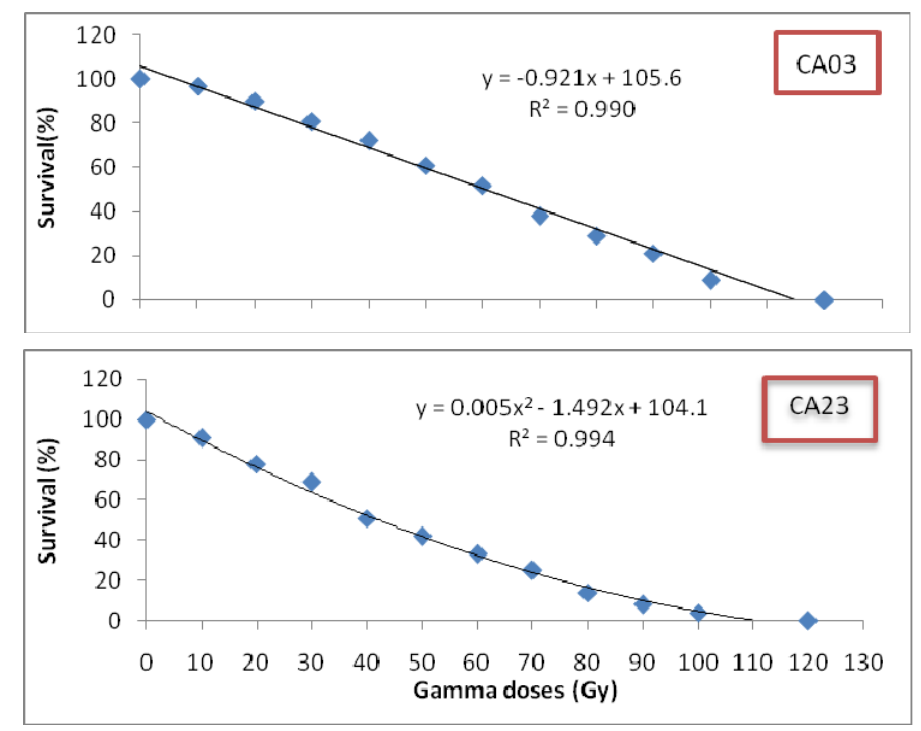
Figure 1. Radiation effect on survival rate (%) for C.